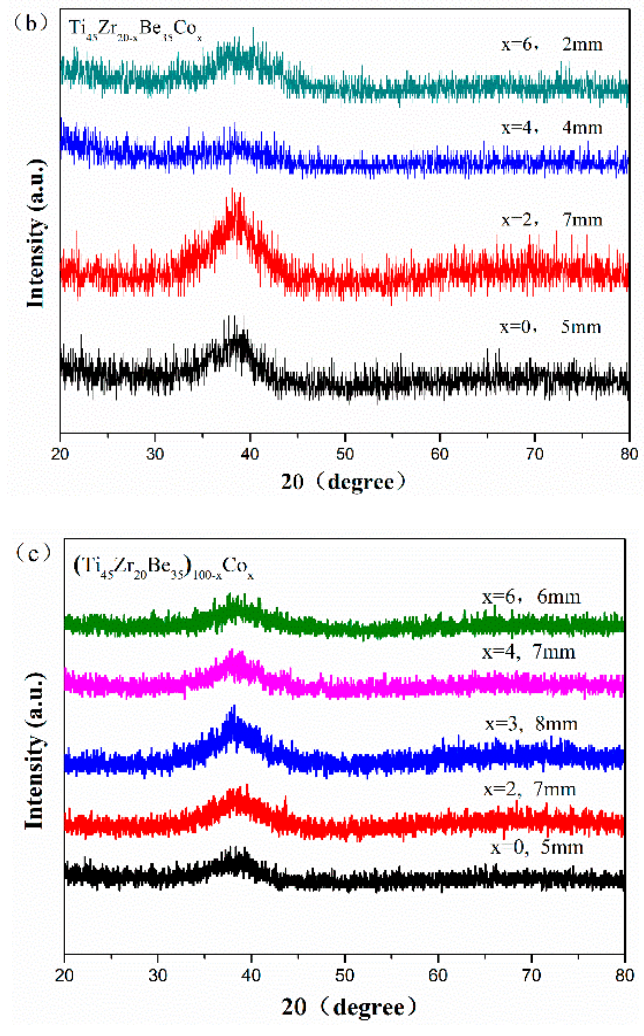
Figure 2. XRD patterns of as-cast. ( a ) Ti 45 Zr 20 Be 35 − x Co x ( x = 0, 2, 4, 6, 8, 10, 12, 14, and 16), ( b ) Ti 45 Zr 20 − x Be 35 Co x ( x = 0, 2, 4, and 6), and ( c ) (Ti 45 Zr 20 Be 35 ) 100 − x Co x ( x = 0, 2, 3, 4, and 6) sections with their critical diameters.